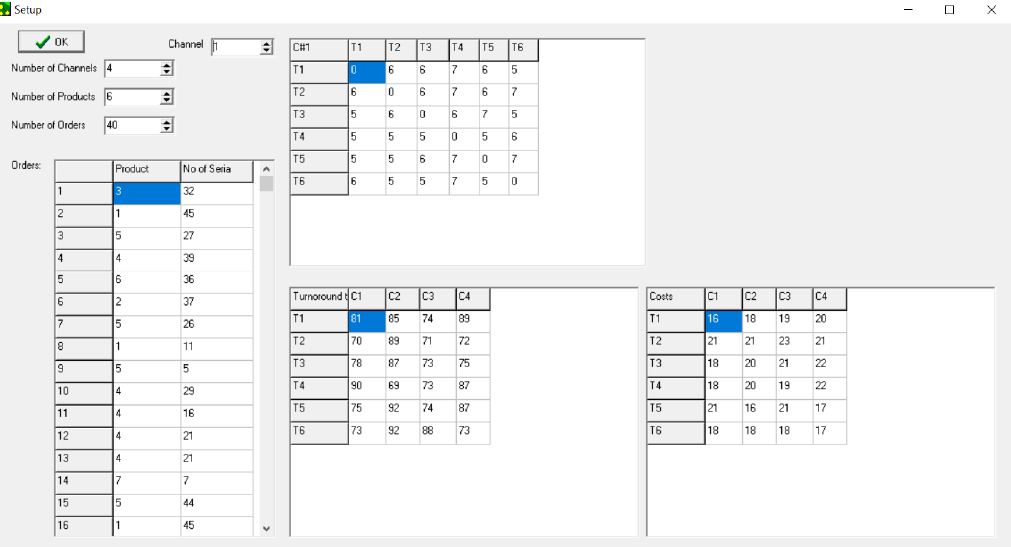
Figure 2. The data of the production scheduling problem (C#i in the computer application means the selected C4 production line).